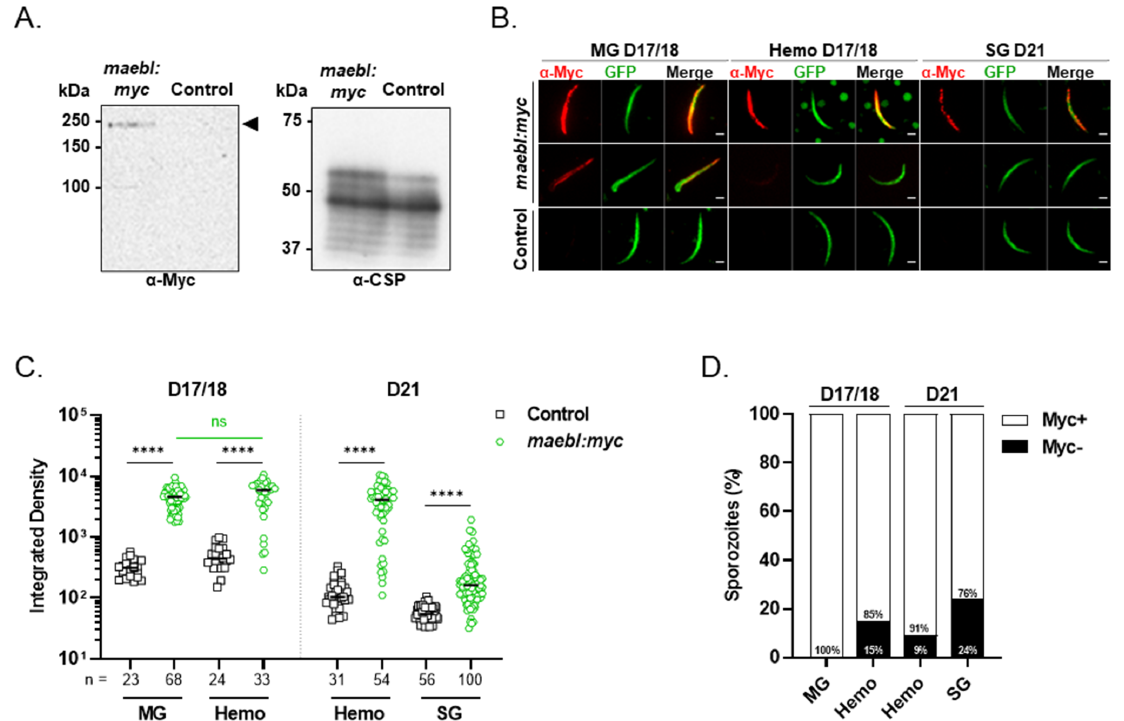
Figure 6. Quantification of myc-tagged MAEBL expression in sporozoites. ( A ) Western blot analysis of myc-tagged MAEBL expression in maebl:myc and Control midgut (MG) sporozoite extracts. Denatured lysates of 8.0 × 10 4 sporozoites were separated on 8% SDS gel and probed with a mouse monoclonal anti-myc tag antibody (clone 4A6). CSP was used as loading control.( B – D ) Quantification of myc-tagged MAEBL expression in sporozoites by immunofluorescence. Sporozoites were collected from the midgut (MG), hemolymph (Hemo) and salivary glands (SG) of mosquitoes infected with Control or maebl:myc parasites, on the indicated days. Sporozoites were fixed, permeabilized and labeled anti-myc tag antibody (clone 4A6). ( B ) Representative immunofluorescence images of maebl:myc and Control sporozoites stained with anti-myc antibodies visualized in red and the GFP reporter in green. For the representation purpose only, the Smooth filter was applied to the GFP channel. Scale bar, 2 µ m. ( C ) Fluorescence intensity of maebl:myc sporozoites, quantified as integrated density. Symbols represent individual sporozoites and bars indicate the median value of each population. Statistical significance was determined using the one-way ANOVA (Kruskal–Wallis test with Dunn’s multiple comparisons test). ( D ) Percentage of myc-positive (Myc+) and negative (Myc − ) sporozoites. maebl:myc sporozoites with a fluorescence intensity superior to the highest value obtained for Control sporozoites were considered positive. ns, non-significant; **** p <